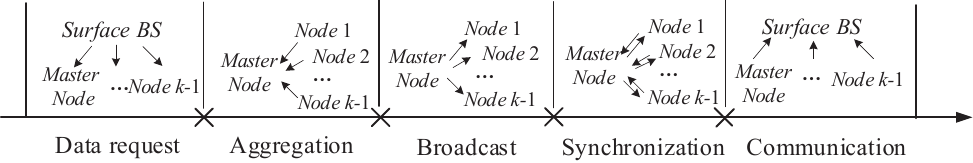
Figure 2. The process diagram of underwater MI-assisted acoustic cooperative MIMO